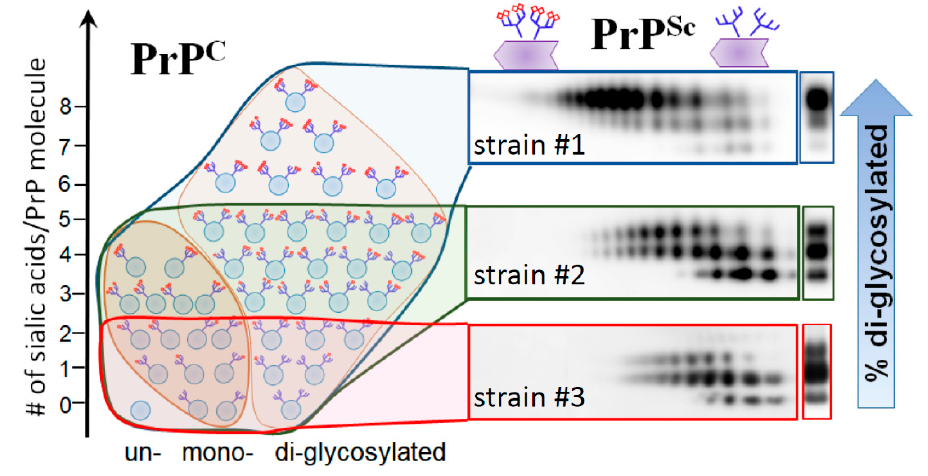
Figure 2. Schematic diagram illustrating selective recruitment of PrP C sialoglycoforms in a strain-specific manner according to the PrP C sialylation status. The left panel shows distribution of PrP C molecules according to their glycosylation status (in horizontal dimension) and sialylation status (in vertical dimension) ranging from non-sialylated to highly sialylated molecules. PrP C molecules are shown as blue circles and sialic acid residues as red diamonds. The panels on the right show 2D Western blots of three prion strains with different recruitment selectivity. While 263K (strain #1) recruits PrP C sialoglycoforms without strong preferences, hypersialylated PrP C molecules are preferentially excluded from RML (strain #2) and excluded even stronger from atypical PrP Sc (strain #3). As a result of strain-specific exclusion of highly sialylated PrP C , ratios of glycoforms within PrP Sc shift toward mono- and unglycosylated glycoform, as illustrated by corresponding 1D Western blots. Adapted from Baskakov and Katorcha 2016 [35].